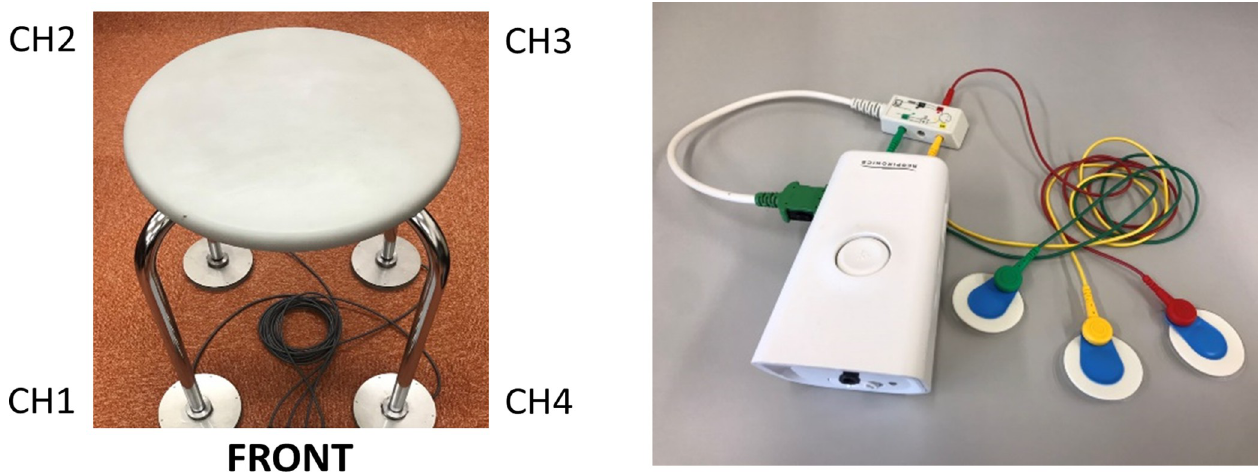
Fig 2. The recording devices; (a) Chair fitted with load-cell sensors; (b) Alice PDx.